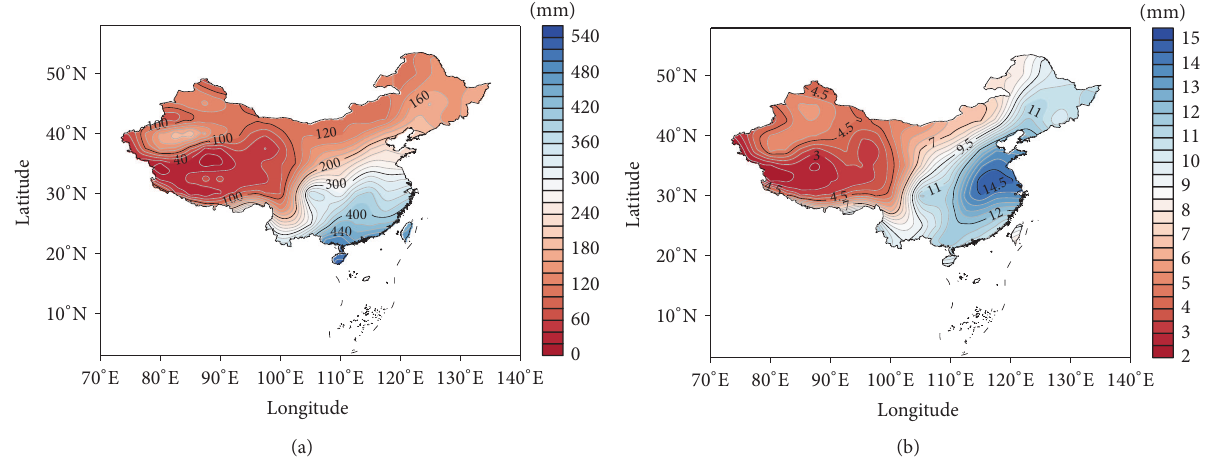
Figure 3: (a) Distribution of annual PW from 1951 to 2015 in China; (b) is similar to (a), but the data shown for the annual average PW are standard deviations.